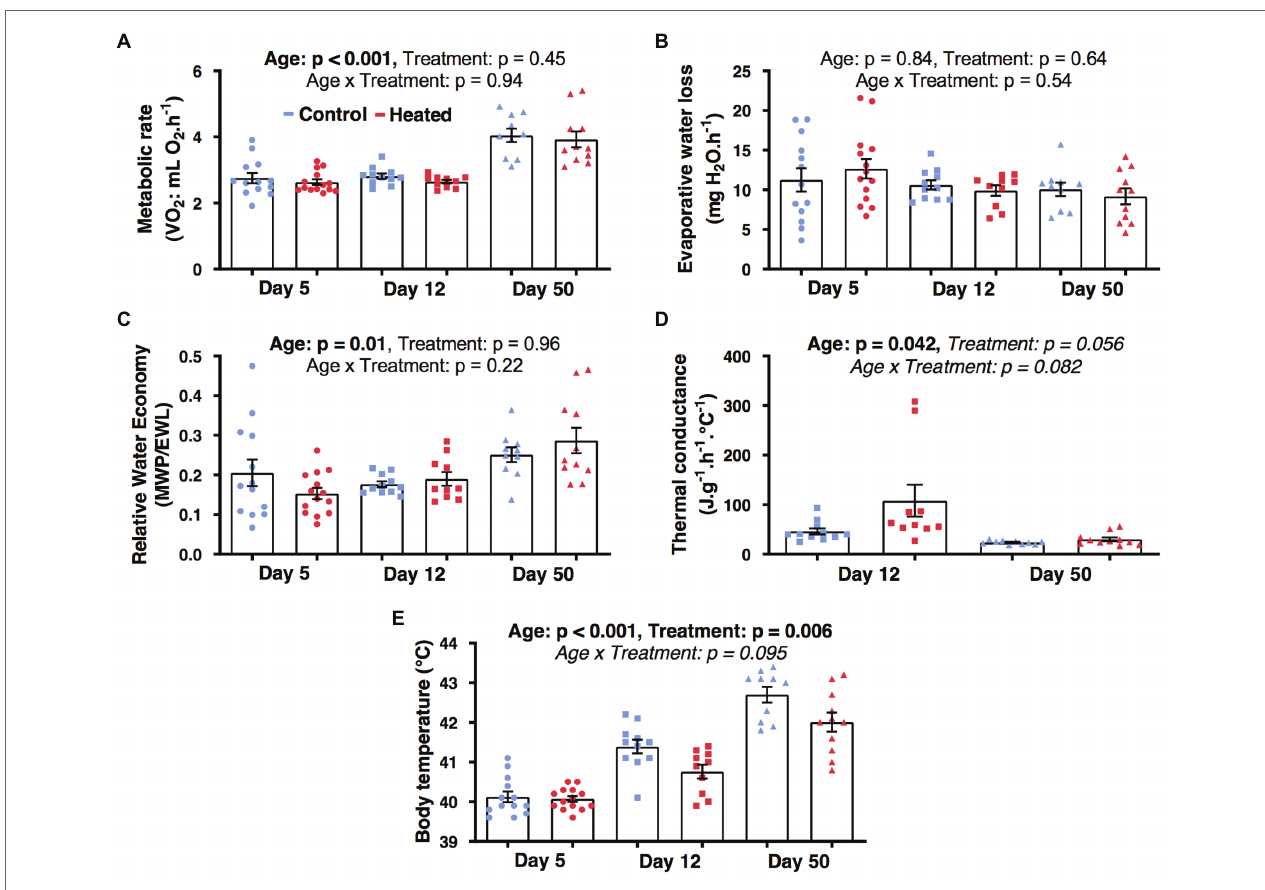
FIGURE 3 | Effects of early-life heat waves exposure in zebra finch on whole-body physiology: (A) metabolic rate (B) evaporative water loss (C) relative water economy (D) thermal conductance, and (E) body temperature after exposure to an ambient temperature of 40 ° C for >2 h. Individuals have been successively measured at day 5 (ectothermic stage), day 12 (poikilothermic stage), and day 50 (homoeothermic stage; 1 month after the treatment ended) post hatch. Individual data points are presented along with their mean ±